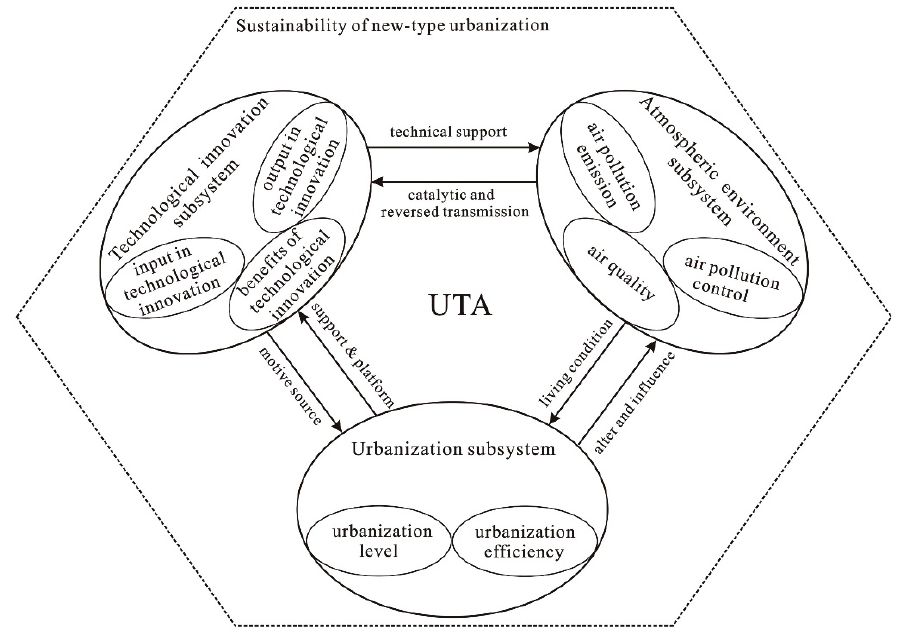
Figure 2. Framework and interaction of three UTA subsystems.